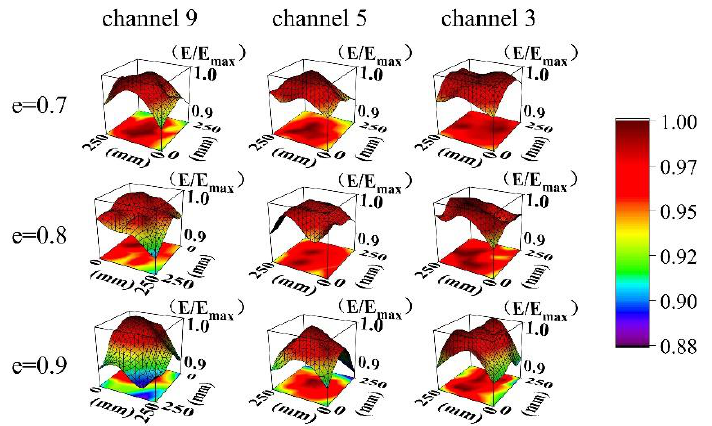
Figure 11. Normalized illuminance distribution of the illuminated area produced by the optical system.